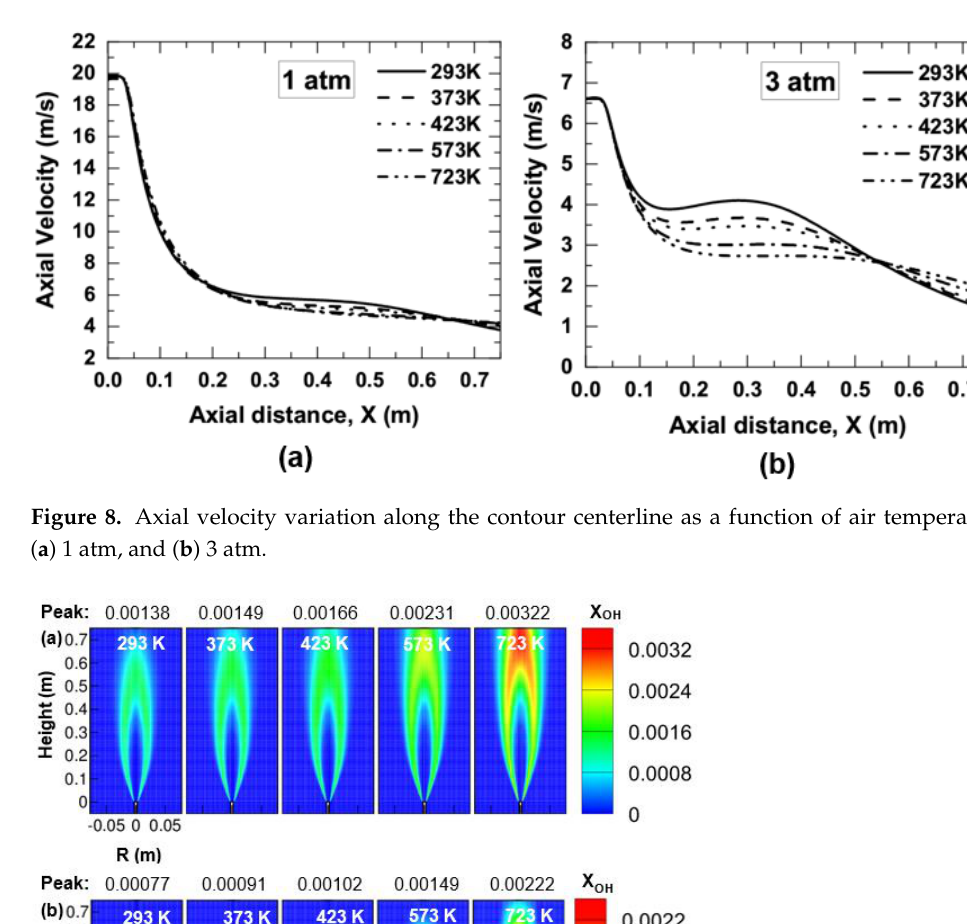
Figure 8. Axial velocity variation along the contour centerline as a function of air temperature; ( a ) 1 atm, and ( b ) 3 atm.